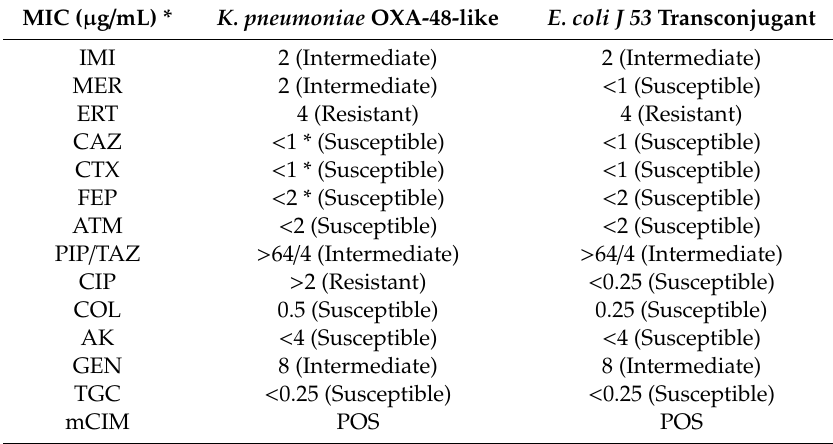
Table 1. Minimal concentration inhibitory of the Klebsiella pneumoniae OXA-48 producer and Escherichia coli J53